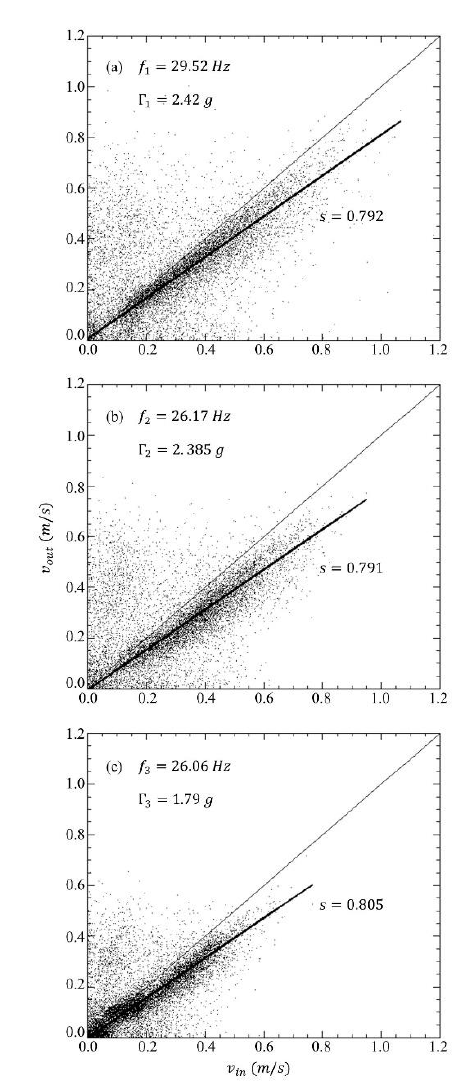
Fig. 3. Plot of relative velocity after collision 𝑣 𝑜𝑢𝑡 against the relative velocity before collision 𝑣 𝑖𝑛 in the lab frame for all data. Parameters are as follows ： (a) 𝑓 1 = 29.52 𝐻𝑧 , Γ 1 = 2.42 𝑔 ; (b) 𝑓 2 = 26.17 𝐻𝑧 , Γ 2 = 2.385 𝑔 ; (c) 𝑓 3 = 26.06 𝐻𝑧 , Γ 3 = 1.79 𝑔 .